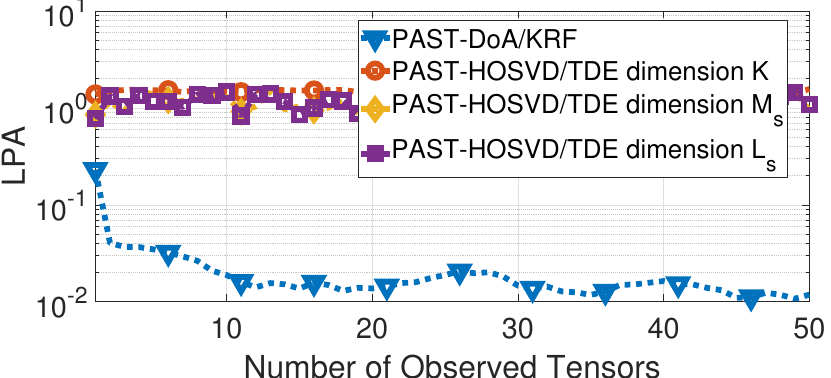
Figure 4. Comparison between the techniques PAST–DoA/KRF and PAST-HOSVD/TDE in terms of